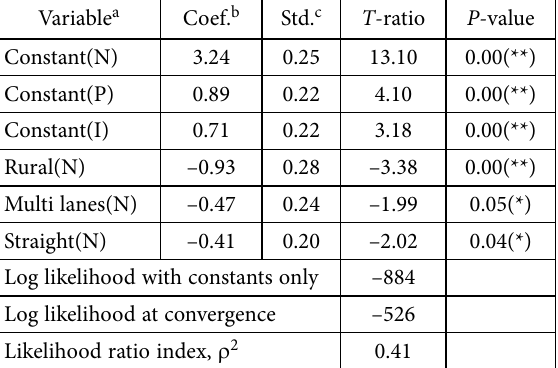
Table 6. Driver’s injury severity model estimation